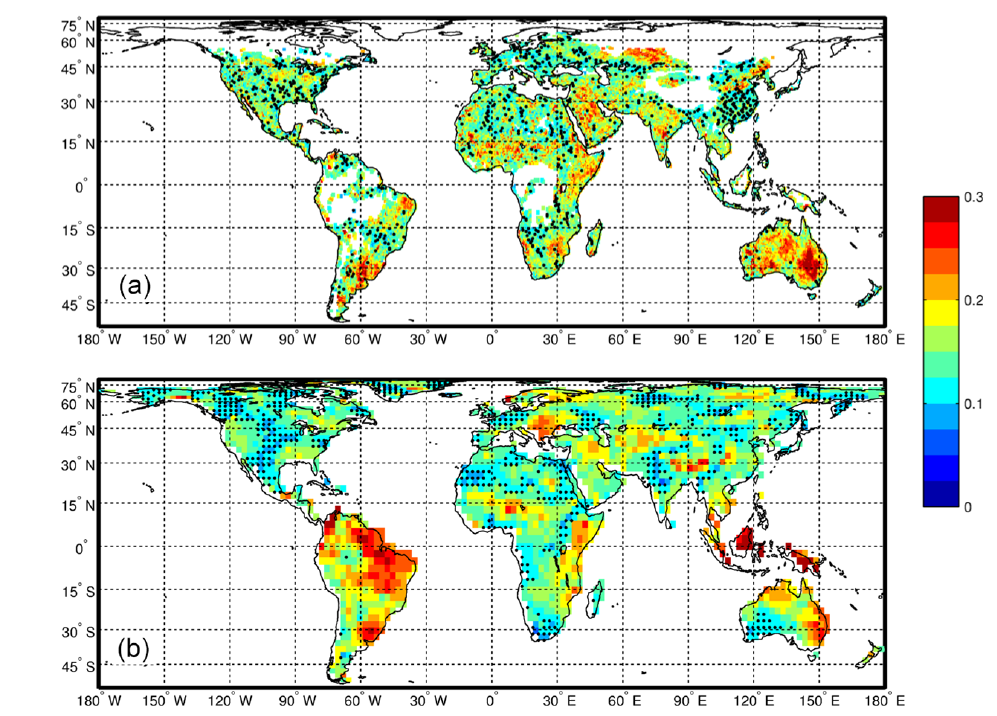
Figure 2. Ratio of the forced variance to the total variance. (a) The fraction of SM variance forced by PRE. (b) The fraction of PRE variance forced by the SM. Dots are placed over areas covered by the forced variable data set but where variance ratio values did not pass a significance test at the 1% level.